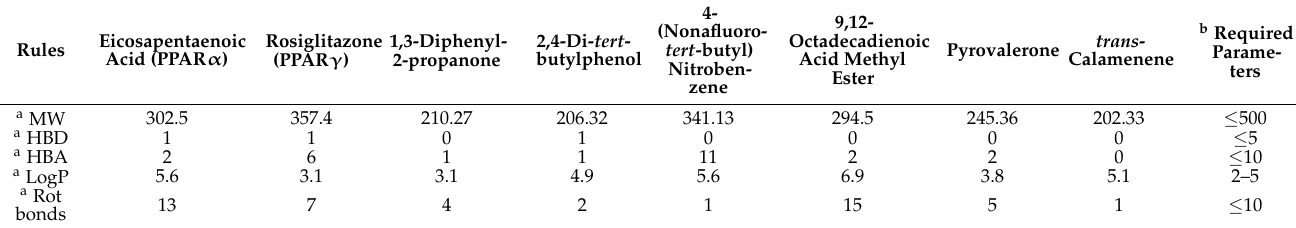
Table 9. Druglikeness properties (Lipinski rule &Veber rule) of cheongukjang specific volatile compounds and controls.